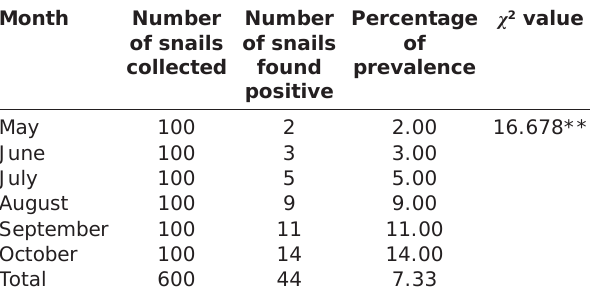
Table-5: Overall month-wise prevalence of different snails having infective stages of parasites in and around